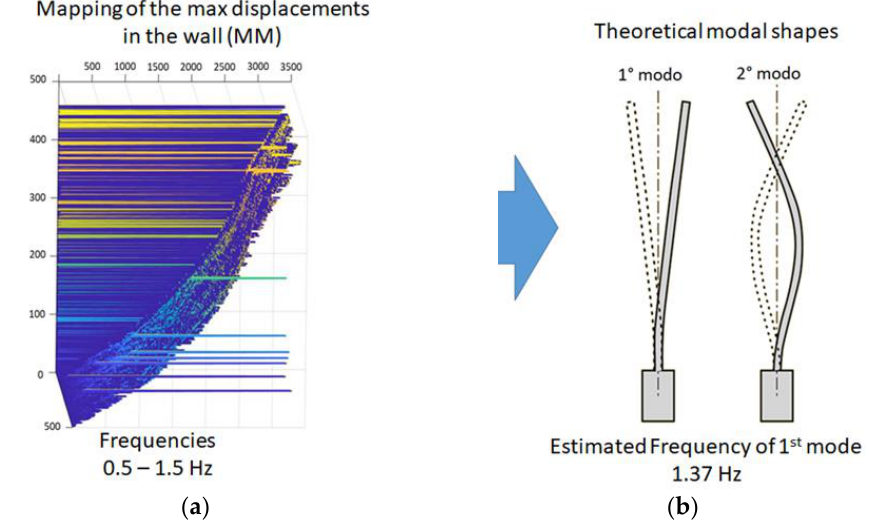
Figure 13. MM analysis of the 16th-century wall: ( a ) mapping of the max displacements of the wall in the frequency range 0.5 – 1.5 Hz; ( b ) theoretical modal shapes of a straight vertical cantilever.